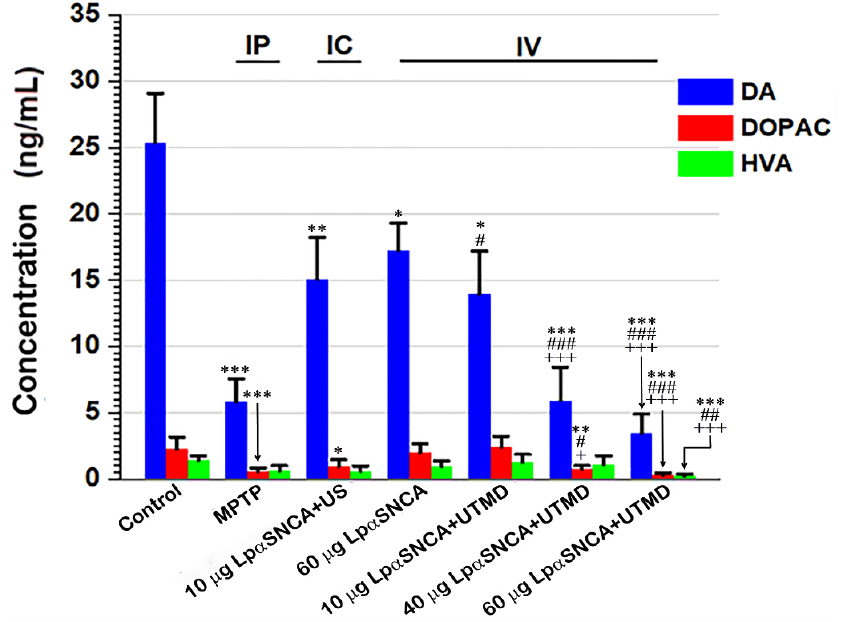
Figure 2. The neurotransmitter level of DA and its metabolites: DOPAC and HVA. Bar graphs represent the mean ± standard deviation, and statistical analyses were performed via ANOVA followed by Tukey’s post hoc test. *, ** and *** indicate p < 0.05, p < 0.01 and p < 0.005 vs. the control group; # , ## and ### indicate p < 0.05, p < 0.01 and p < 0.005 vs. the IC-Lp α SNCA + US group; + and +++ indicate p < 0.05 and p < 0.005 vs. the IV-Lp α SNCA group; n ≥ 5 for each group. MPTP = 1-methyl-4-phenyl-1,2,3,6-tetrahydropyridine; US = focused ultrasound;